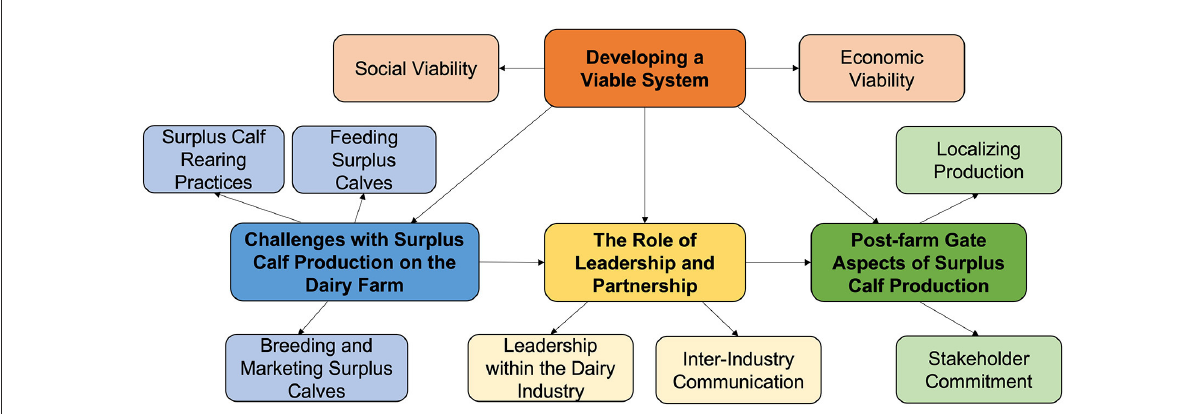
FIGURE2 Concept map depicting possible relationships between major themes (bolded) and sub-themes that arose from a series of group discussions with dairy producers and allied industry regarding surplus calves. The dark orange, dark yellow, dark blue, and dark green boxes represent the four overarching key themes that emerged from discussions. The lighter boxes within each color represent sub-themes within each of the key themes. Arrows are used to demonstrate organization of the